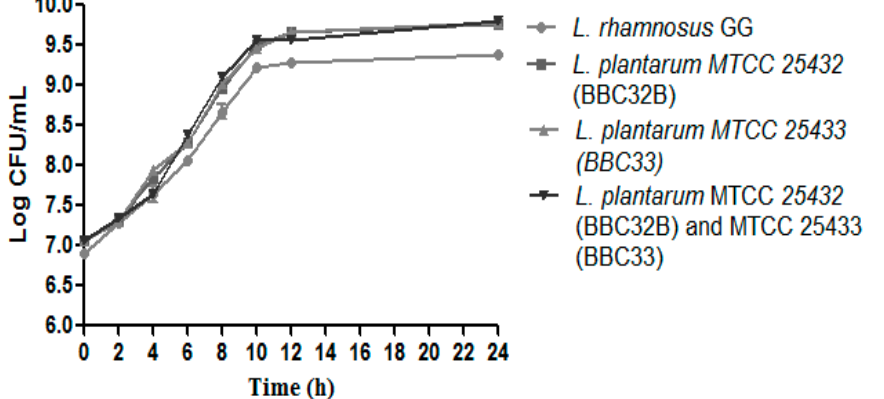
Figure 1. Growth pattern evaluation: A higher growth pattern of the probiotic strains L. plantarum MTCC 25432 (BBC32B), L. plantarum MTCC 25433 (BBC33) and combination of L. plantarum MTCC 25432 (BBC32B) and MTCC 25433 (BBC33) in comparison to control L. rhamnosus GG in term of log CFU/mL. The values are expressed as mean ±SEM of three independent experiments with signifi- cant difference ( p <0.0001).